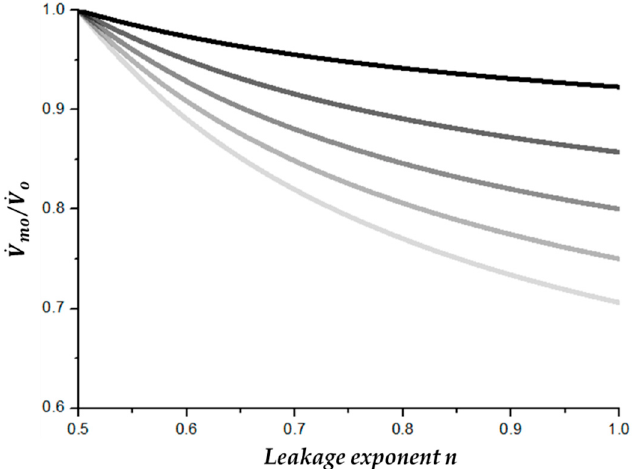
. . V mo / V o change with change of leakage exponent n . A lighter shade Figure 2. Schematic diagram of Figure 2. Schematic diagram of (cid:1848)(cid:4662) (cid:3040)(cid:3042) (cid:1848)(cid:4662) (cid:3042) ⁄ change with change of leakage exponent (cid:1866) . A lighter shade indicates that the density of the agent-air mixture indicates that the density of the agent-air mixture increases.